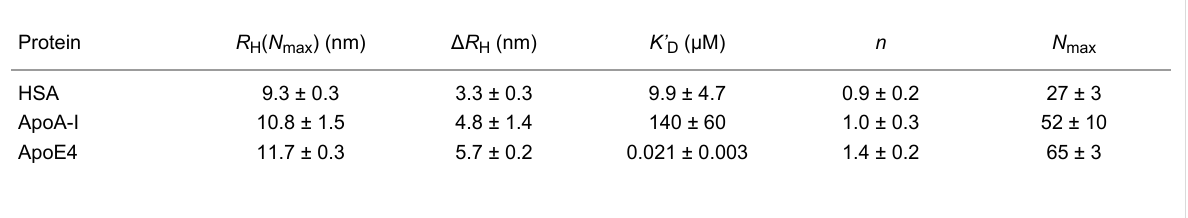
Table 1: Parameters of protein adsorption onto FePt